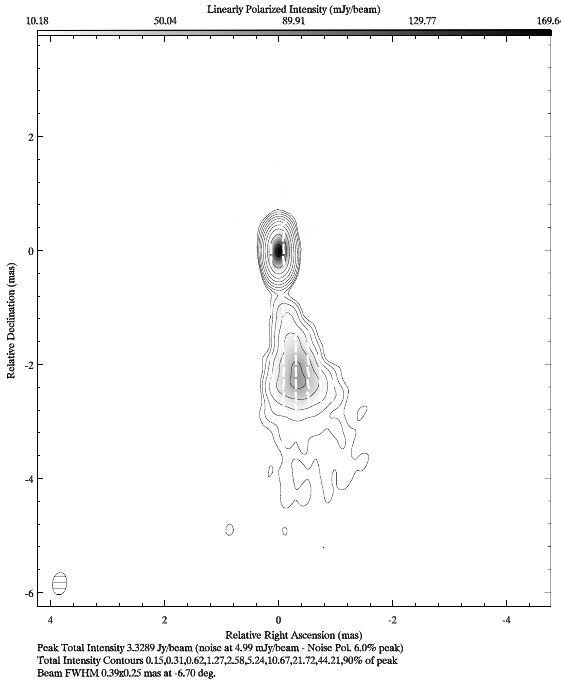
Figure 2. Same as Figure 1 at 22 GHz.